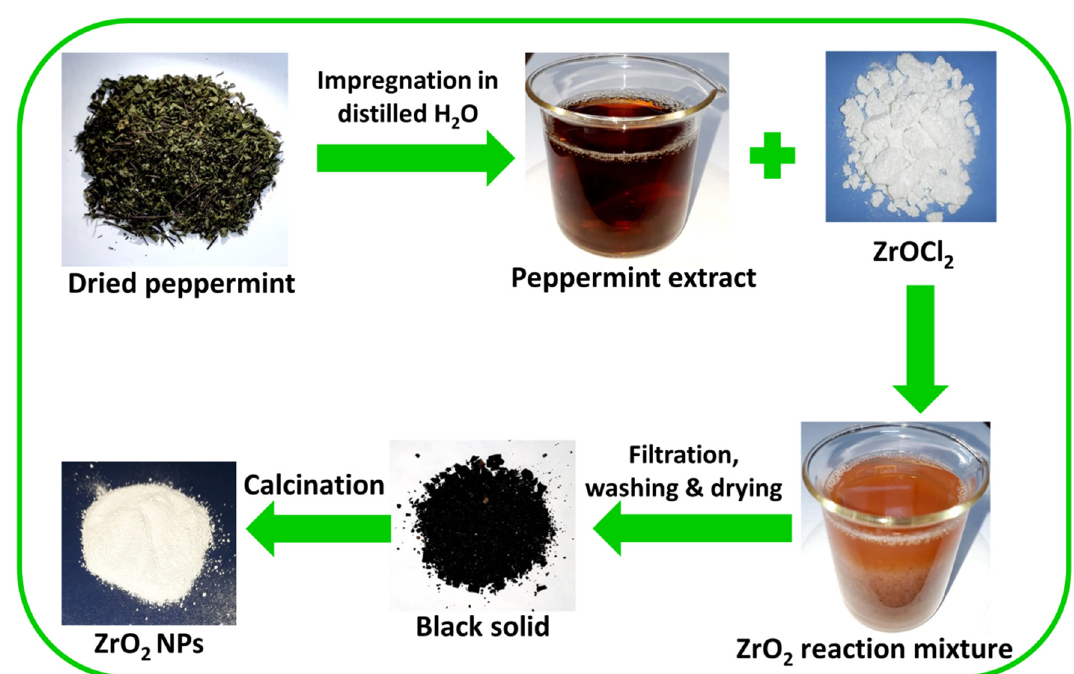
Scheme 2. Green synthesis of ZrO2 NPs from